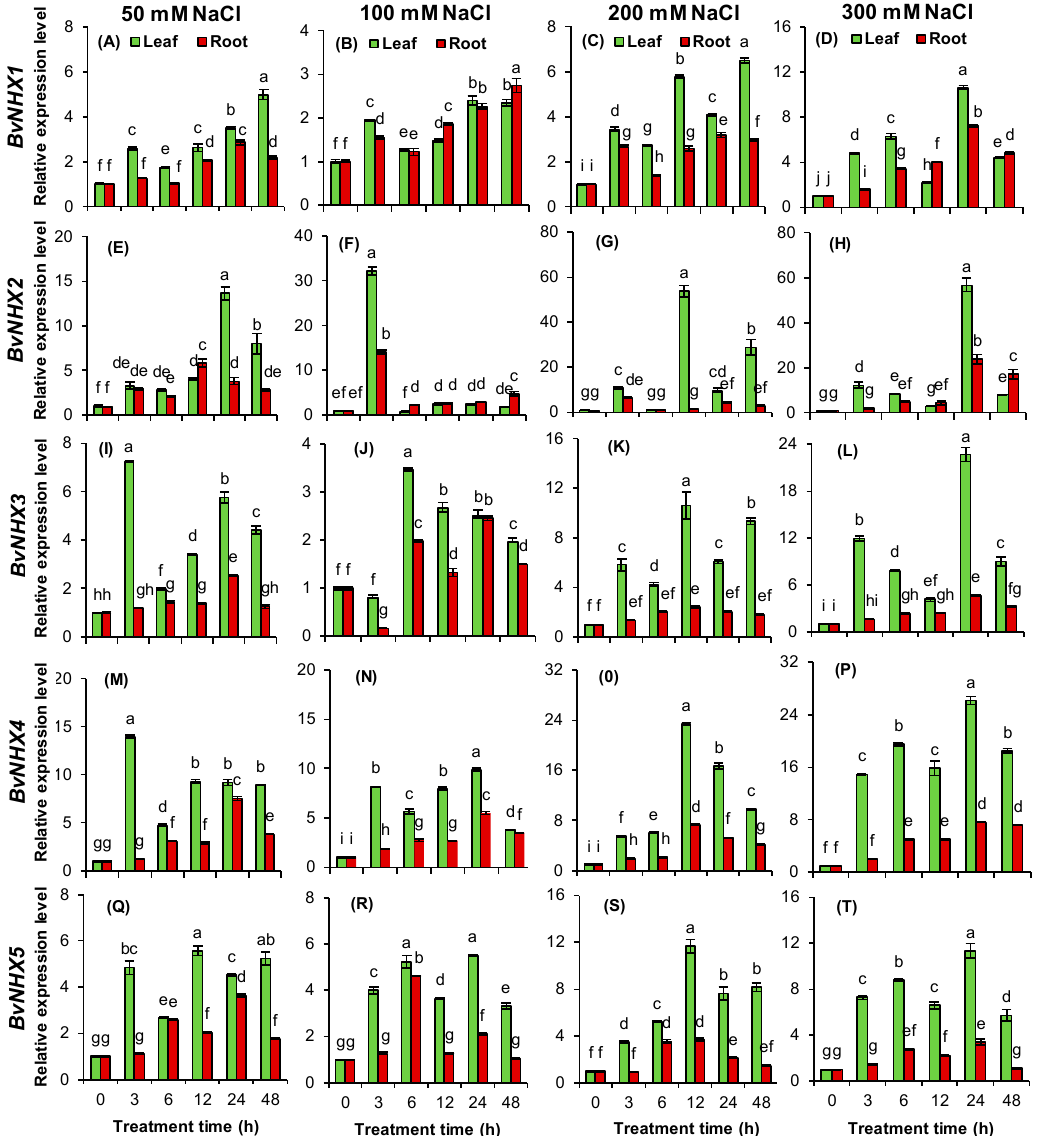
Figure 6. Relative expression levels of BvNHX genes in leaf and root of sugar beet seedlings subjected to 50, 100, 200, and 300 mM NaCl for 0, 3, 6, 12, 24, and 48 h. Expression of the BvNHX genes normalized to those of BvACTIN and shown relative to the expression at 0 h. The 2 −ΔΔ Ct method was used to calculate the expression levels of BvNHX genes at different time. Experiments were repeated at least 3 times. Values are means ± SE and bars indicate SE ( n = 3 ). Columns with different letters represent significant differences at p < 0.05 level (Duncan’s test).